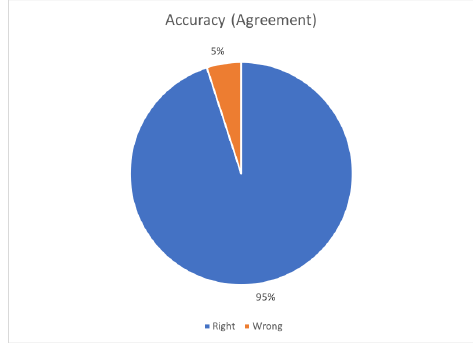
Figure 12. Accuracy achieved with highest precision aggregation